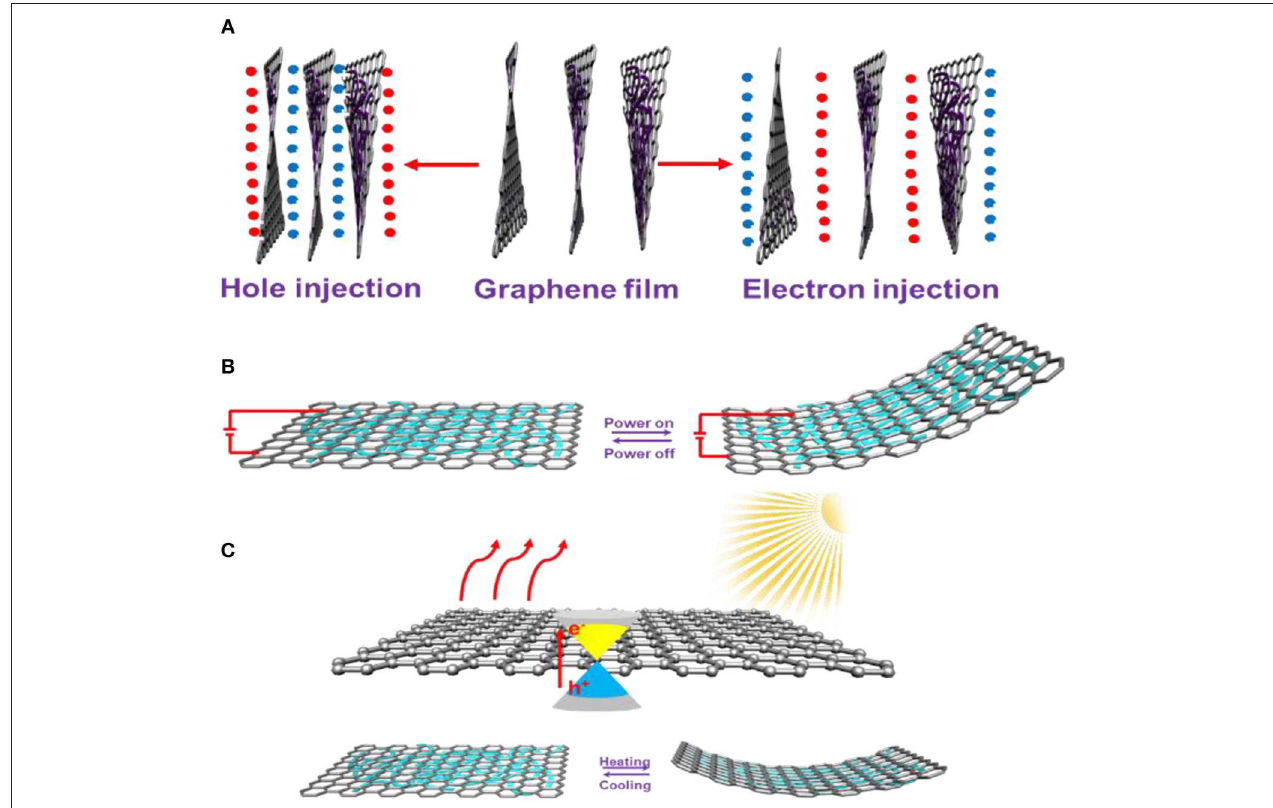
FIGURE 4 | (A) Schematic illustration of electrons charge or discharge into the graphene films. (B) The stretching or bending behaviors of graphene under the electrical stimulus. (C) The conversion of kinetic vibration energy to heat motion energy through infrared-phonon interactions.